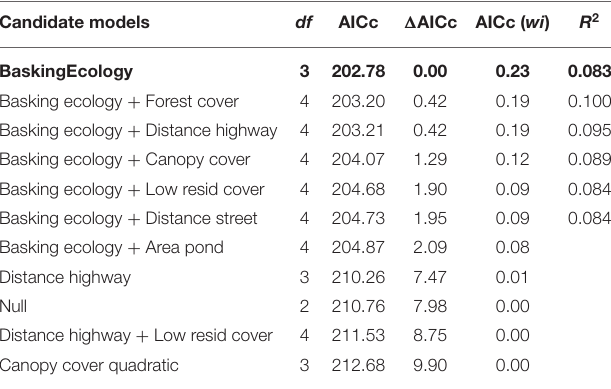
TABLE 1 | Selection parameters of candidate generalized linear mixed models explaining variation in Salmonella prevalence rates of turtles. Candidate